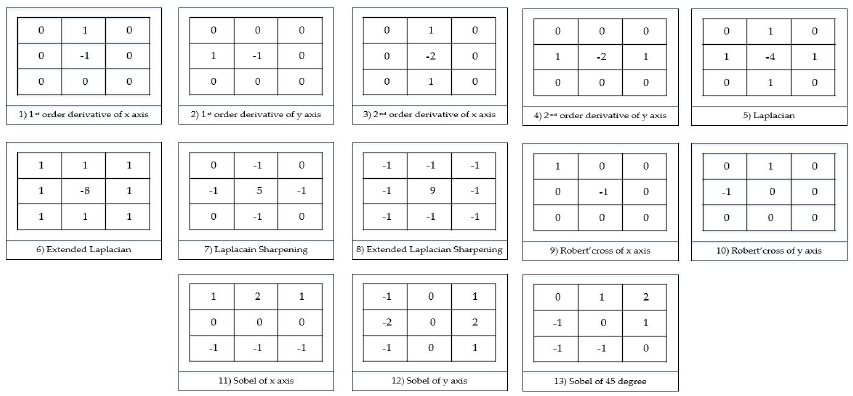
Figure 8. The characteristics of 13 filtering